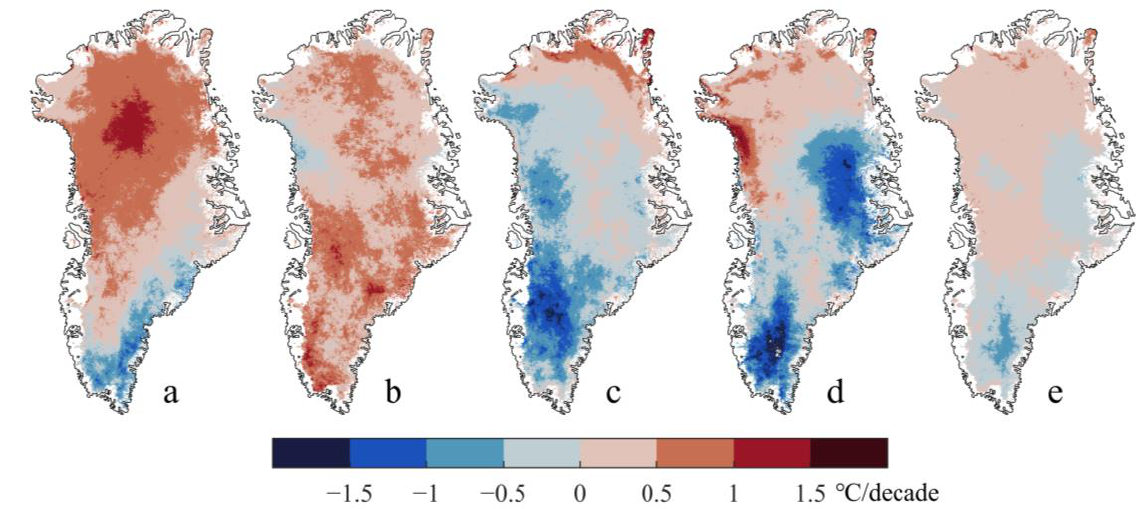
Figure 9. Seasonal MODIS IST trends over the GrIS in spring ( a ), summer ( b ), autumn ( c ) and winter ( d ) from March 2000 to December 2019 and the annual MODIS IST ( e ).